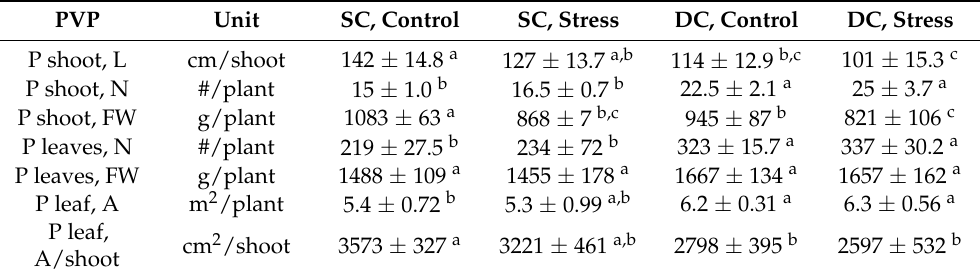
Table 3. Overview of primary vegetative parameters (PVP) as measured in the water deficit groups (WD). Values represent group averages ( ± STD). Different letters (a, b, c) indicate significant differ- ences between groups. Keys: P = Primary, L = length, N = number, FW = fresh weight, A = area, SC = single cane, DC = double cane.